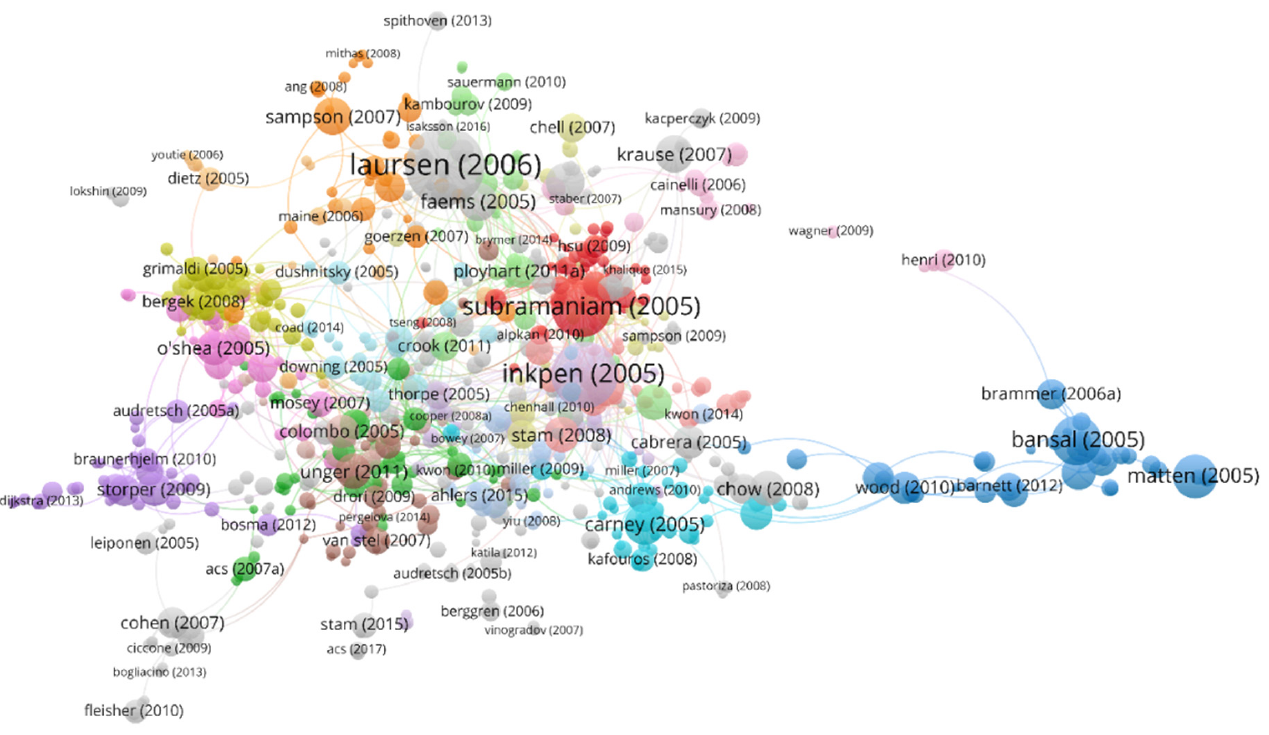
Figure 4. Most cited publications on the research topic: the structures of incubation and accel- eration and the performance of technology-based ventures. (Source: Own elaboration using the VOSviewer